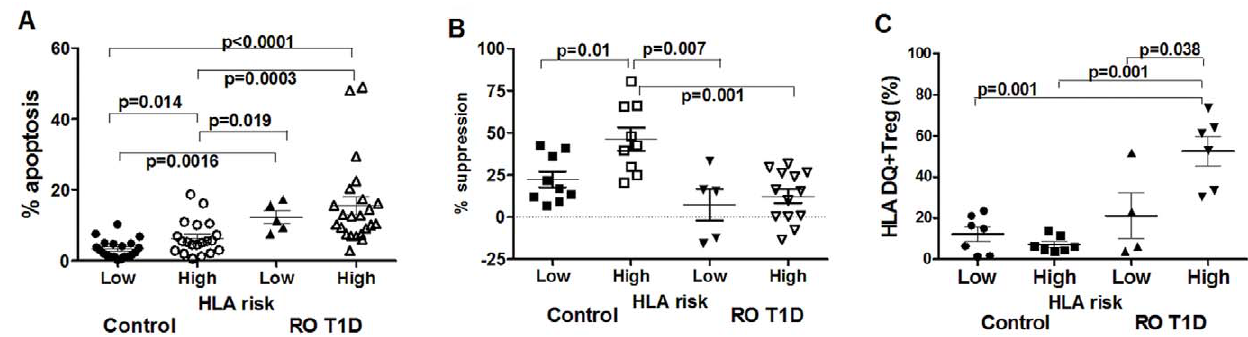
Figure 1. Treg apoptosis, function and surface HLA DQ relative to HLA risk in healthy control and RO T1D subjects. A) Healthy High HLA risk control subjects show significantly increased Treg apoptosis levels (ANOVA F=10.24 df(3,64), p , 0.0001). Detailed significance presented in